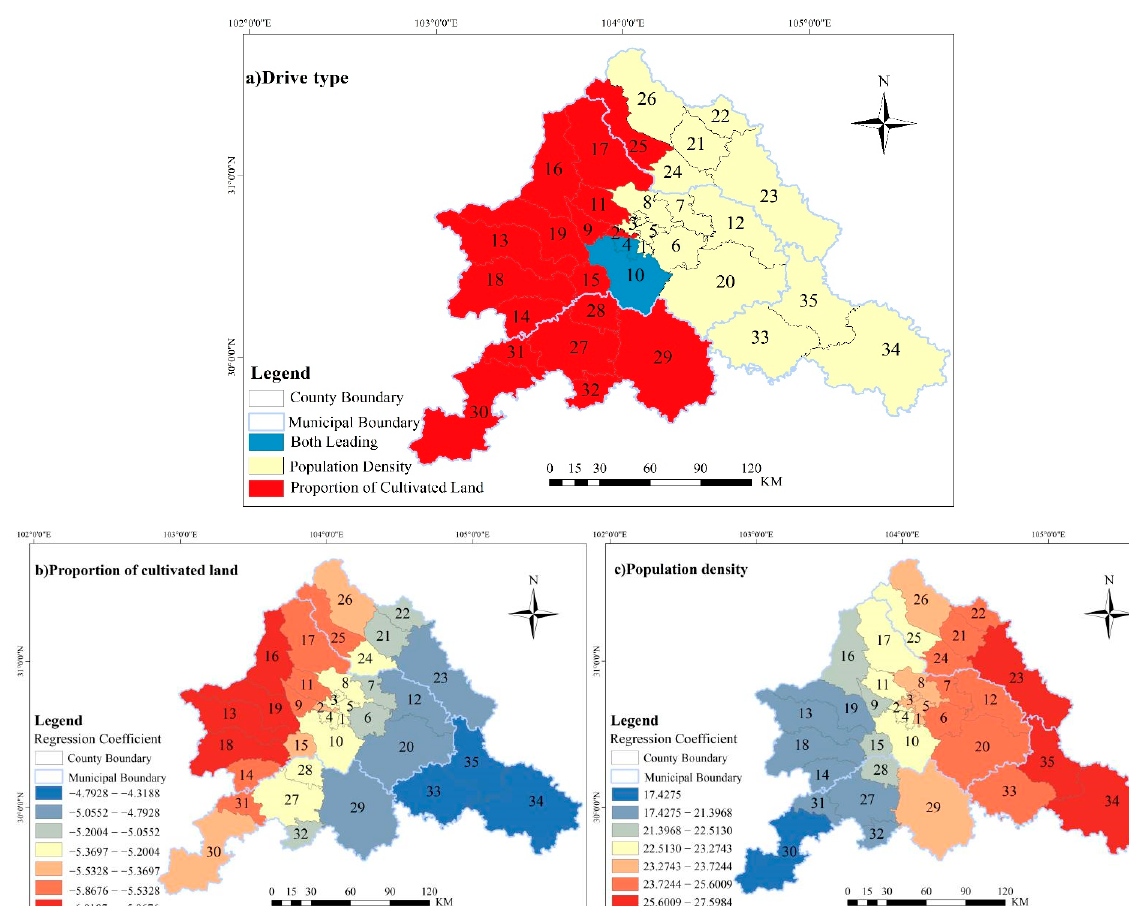
Figure 4. Dominant factors and driver types from 2000 to 2005: ( a ) Distribution pattern of dominant drive types; ( b ) Regression coefficient of the proportion of cultivated land; ( c ) Regression coefficient of population density. From 2005 to 2010, regions dominated by total per capita fixed asset investment in- cluded 12 districts (cities and counties), such as Hongya and Pujiang (Figure 5a). Regions cluded nine districts (cities and counties), such as Jianyang, Wenjiang, and Lezhi. The pro- portion of non-farm population influenced urban expansion occupying cultivated land more than the other indicators in six districts (cities and counties) of Deyang District as well as Dujiangyan, Mianzhu, and other regions (cities and counties) in northern Chengdu City. This is closely related to the accelerated population urbanization during post-disas- ter reconstruction. Specifically, the proportion of non-farm population and total per capita fixed asset investment were both positively related to urban expansion occupying culti- vated land. In contrast, the regression coefficient of the non-farm population decreased from east to west (Figure 5b), while the regression coefficient of per capita fixed asset in- vestment decreased from north to south (Figure 5c). The governments of Hongya County, Qingshen County, Renshou County, and Ziyang City increased local fixed asset invest- ment continuously in this period. In Dujiangyan, Pengzhou, Shifang, Mianzhu, and Luojiang, the total fixed asset investments were slightly correlated with the urban expan-